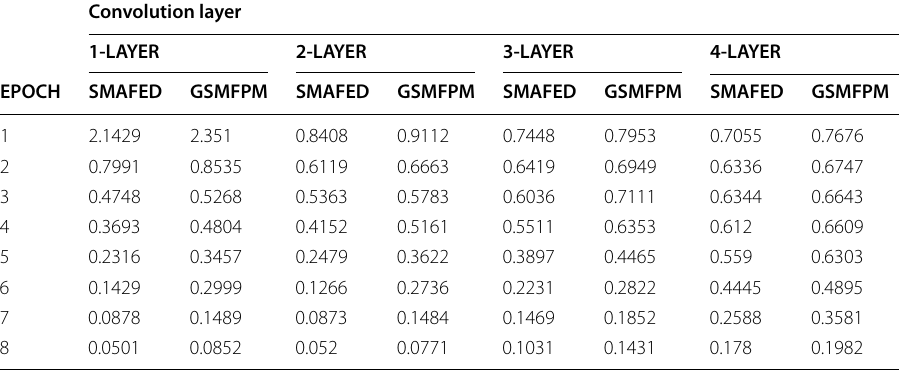
Table 14 Four-Layer convolutional neural network cross-entropy loss function for GSMFPM and SMAFED on Naija-tweets